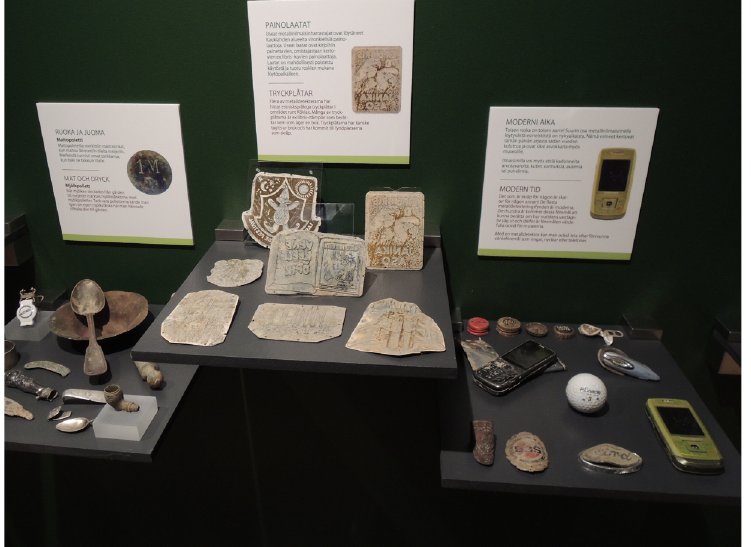
Fig. 1. A view from the exhibition Mysteries from the ground: Metal detecting as a hobby at Glims Farmstead Museum in Espoo, Finland. Photograph by Anna Wessman, Espoo City